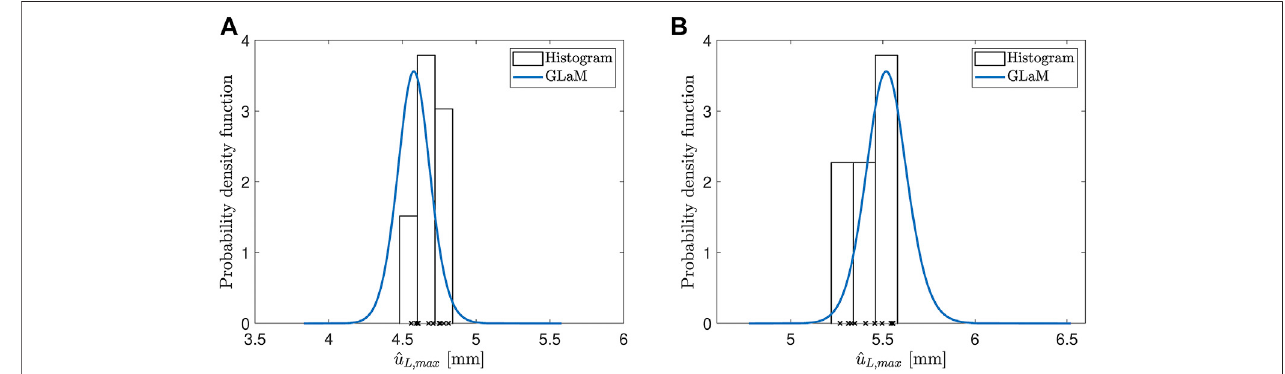
FIGURE 8 | PDF of ^ u L , max predicted by the GLAM versus empirical distributions for ED points: (A) 58 and (B) 157. Cross markers denote the 10 related repetitions for each point.